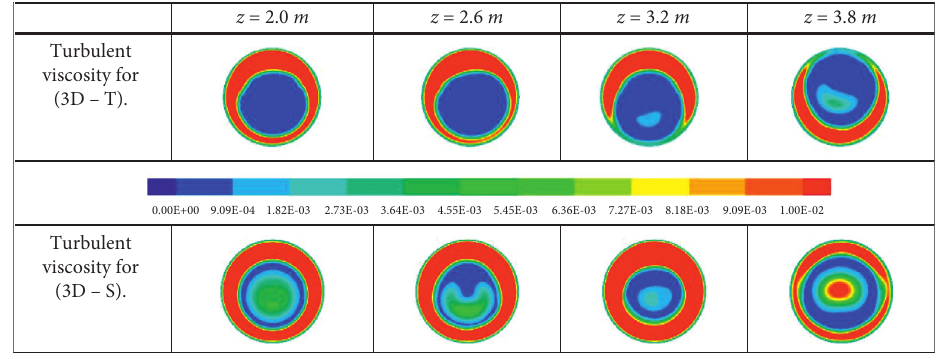
Figure 8: Comparison of the turbulent viscosity in the xy -plane for 3D-T and 3D-S